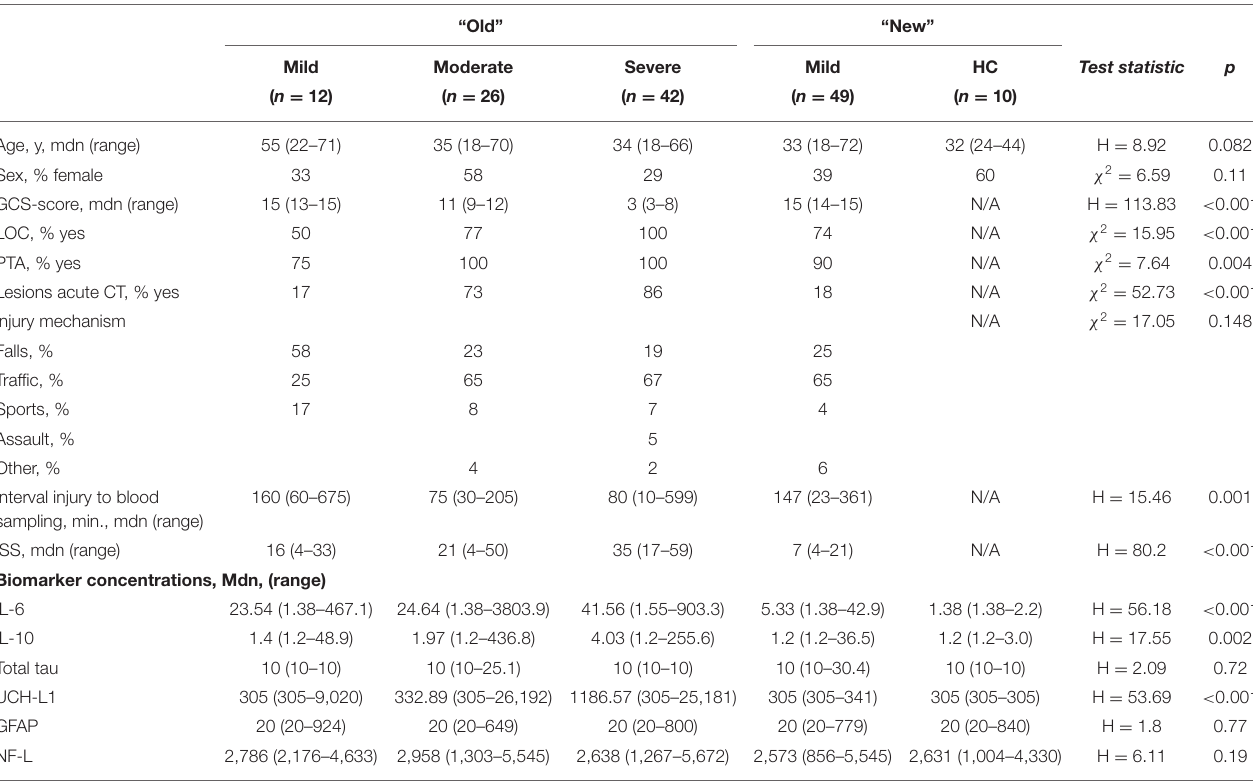
TABLE 1 | Demographics, clinical parameters, and biomarker